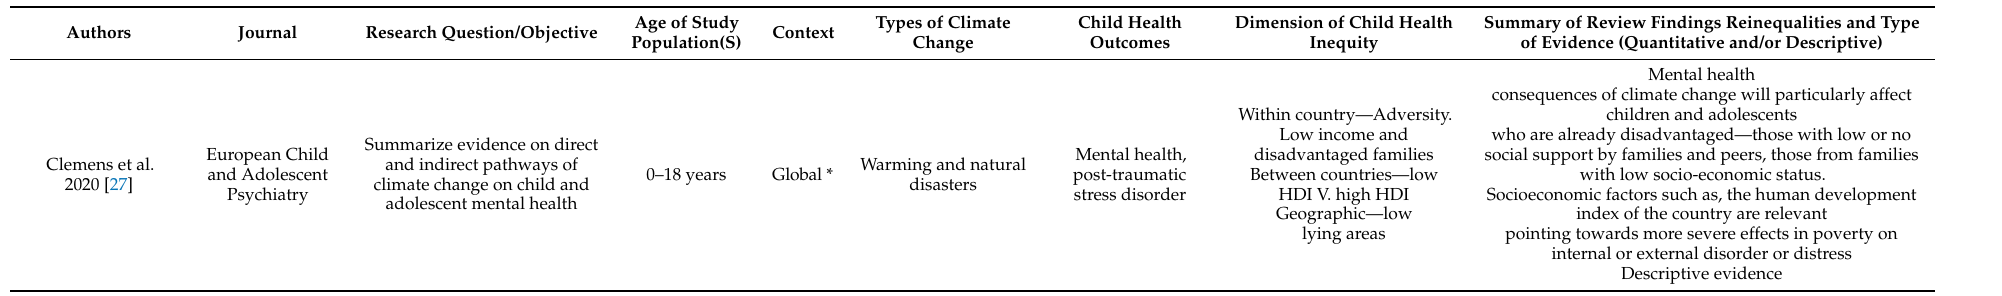
Table 4. Narrative reviews and opinion